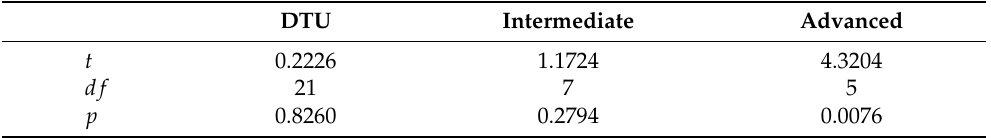
Table 9. The paired t-test results for CasMVSNet [35] with our semi-dense pseudo-labels on the DTU dataset and the Tanks and Temples dataset (significance level α =